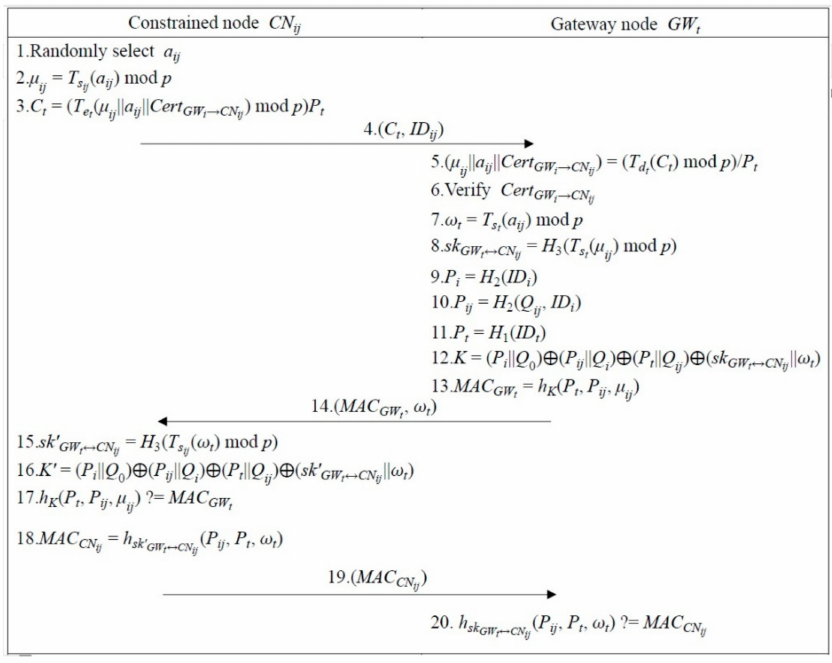
Figure 5. Mutual authentication and key agreement phase of proposed